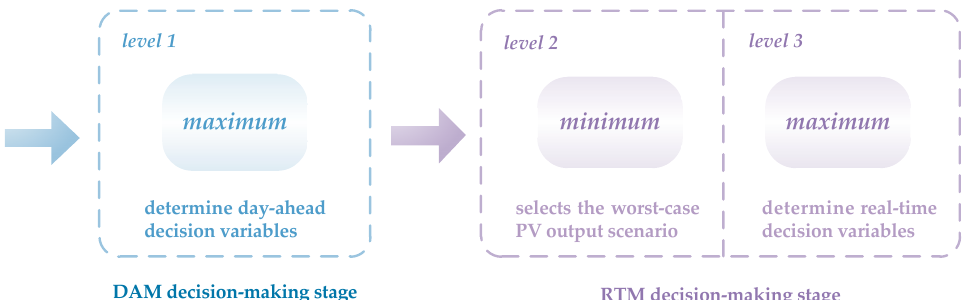
Figure 3. Diagram of the three-level stochastic adaptive robust model.